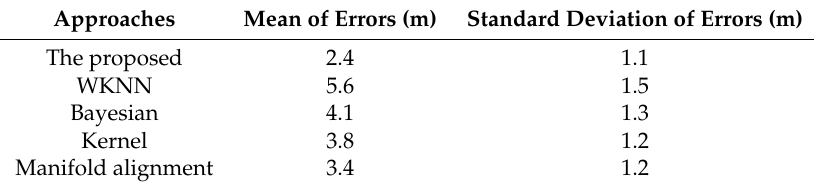
Table 2. Mean and standard deviation of errors by different